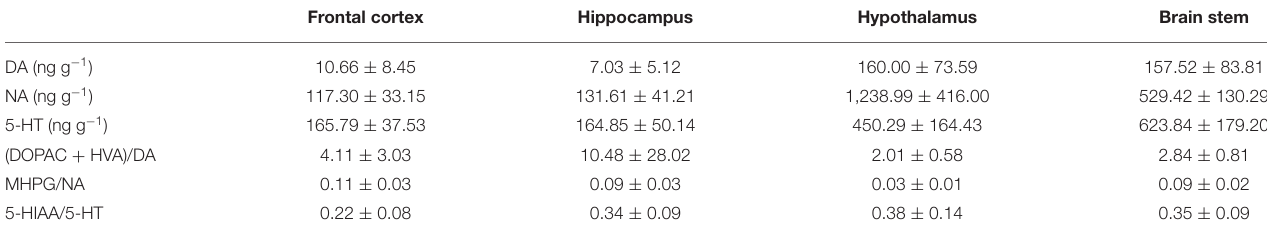
The turnover rates were calculated based on moles per milligram of the respective